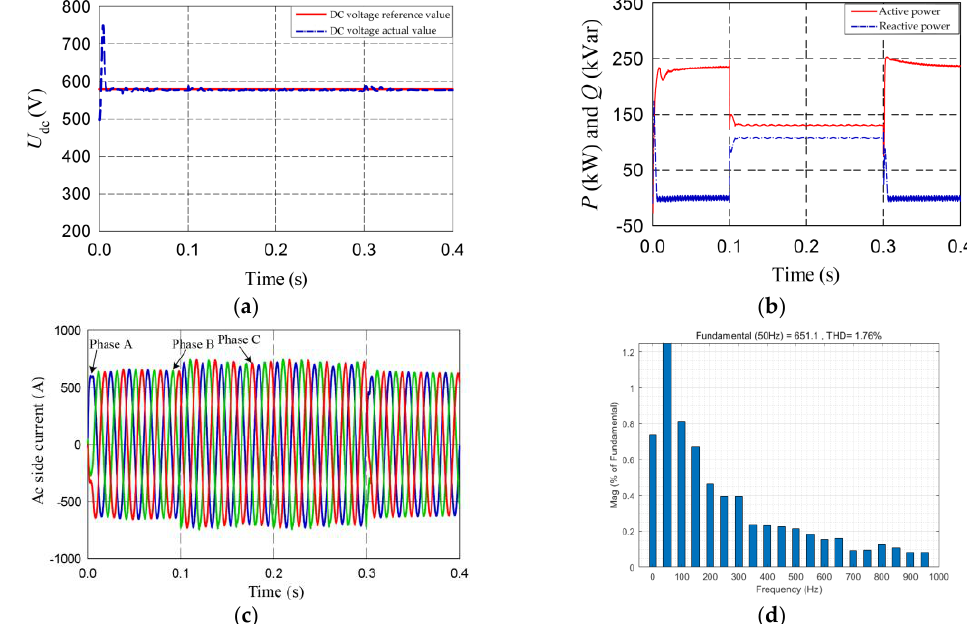
Figure 19. Operating characteristics and waveforms in case of three-phase voltage sag under strategy Three: ( a ) DC bus voltage; ( b ) Active and reactive output power of the inverter; ( c ) Grid current; ( d ) The THD of grid current.